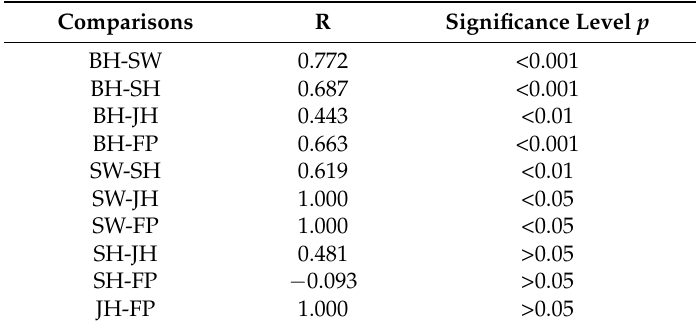
Table 3. R-values and p -values resulting from the Analysis of Similarities (ANOSIM) detected for comparisons of the fish community compositions between the five assessed habitat types JH = structured shallow water zones, BH = bank habitats, SW = former river course below the spillway, SH = fast flowing instream habitat with gravel, FP = nature like fish